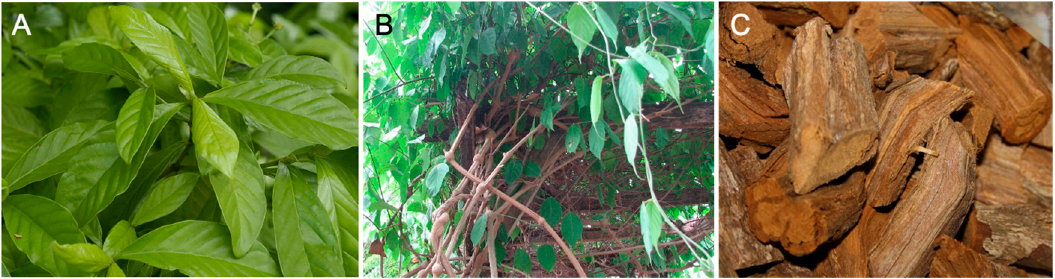
Figure 1. Psychotria viridis ( A ) and Banisteriopsis caapi ( B , C ), the most common admixture plant species used in ayahuasca preparations.